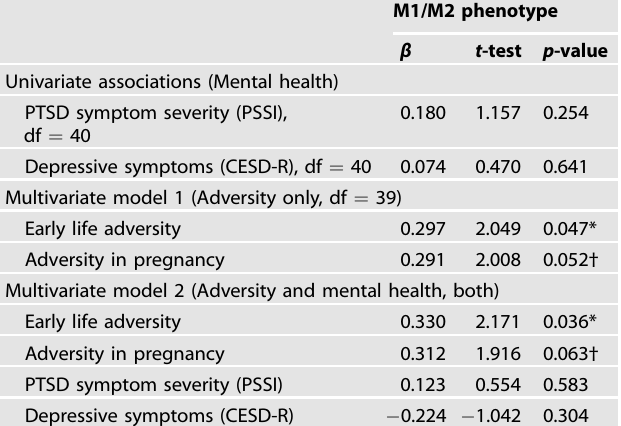
Table 3. Univariate and multivariate associations of adversity during sensitive periods and mental health symptoms with the M1/M2